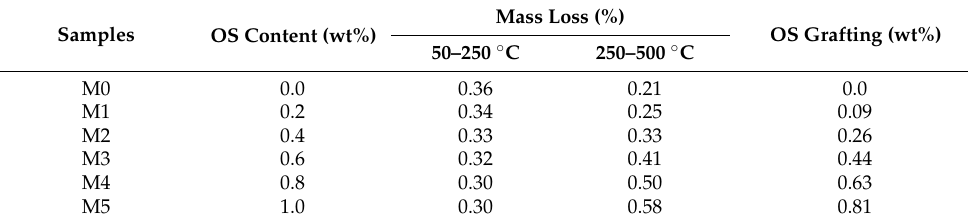
Table 2. Mass loss and the grafting ratio of various OS-modified AlN powder.